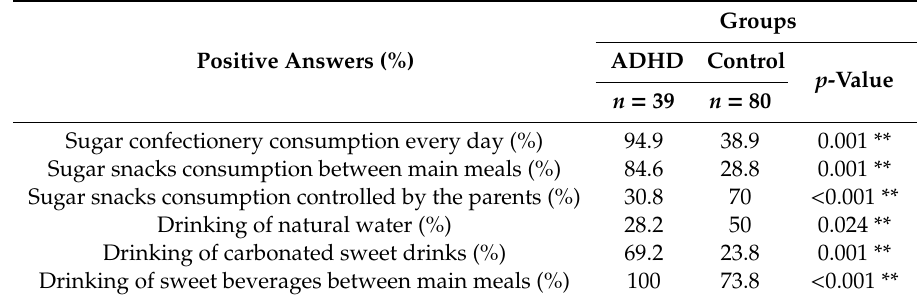
Table 5. Statistical analysis of questionnaire results related to food / drink-related questions (%).